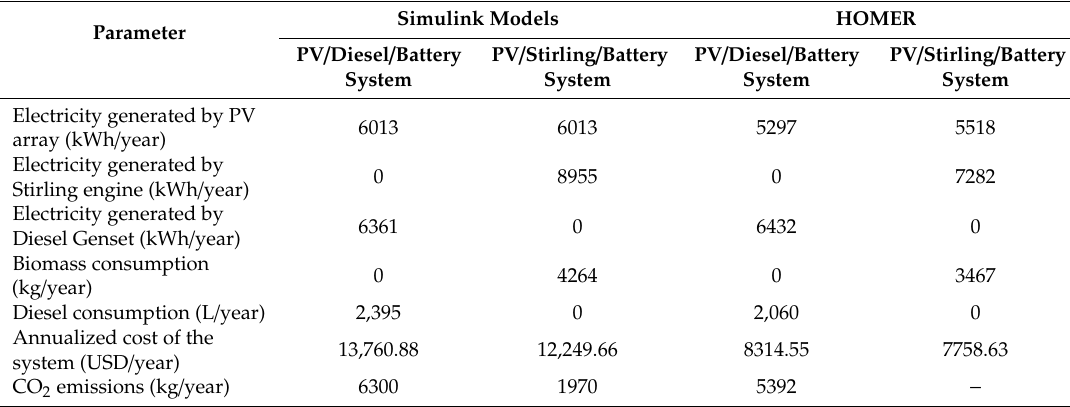
Table 9. Comparison of one-year simulation results between Simulink models and HOMER.